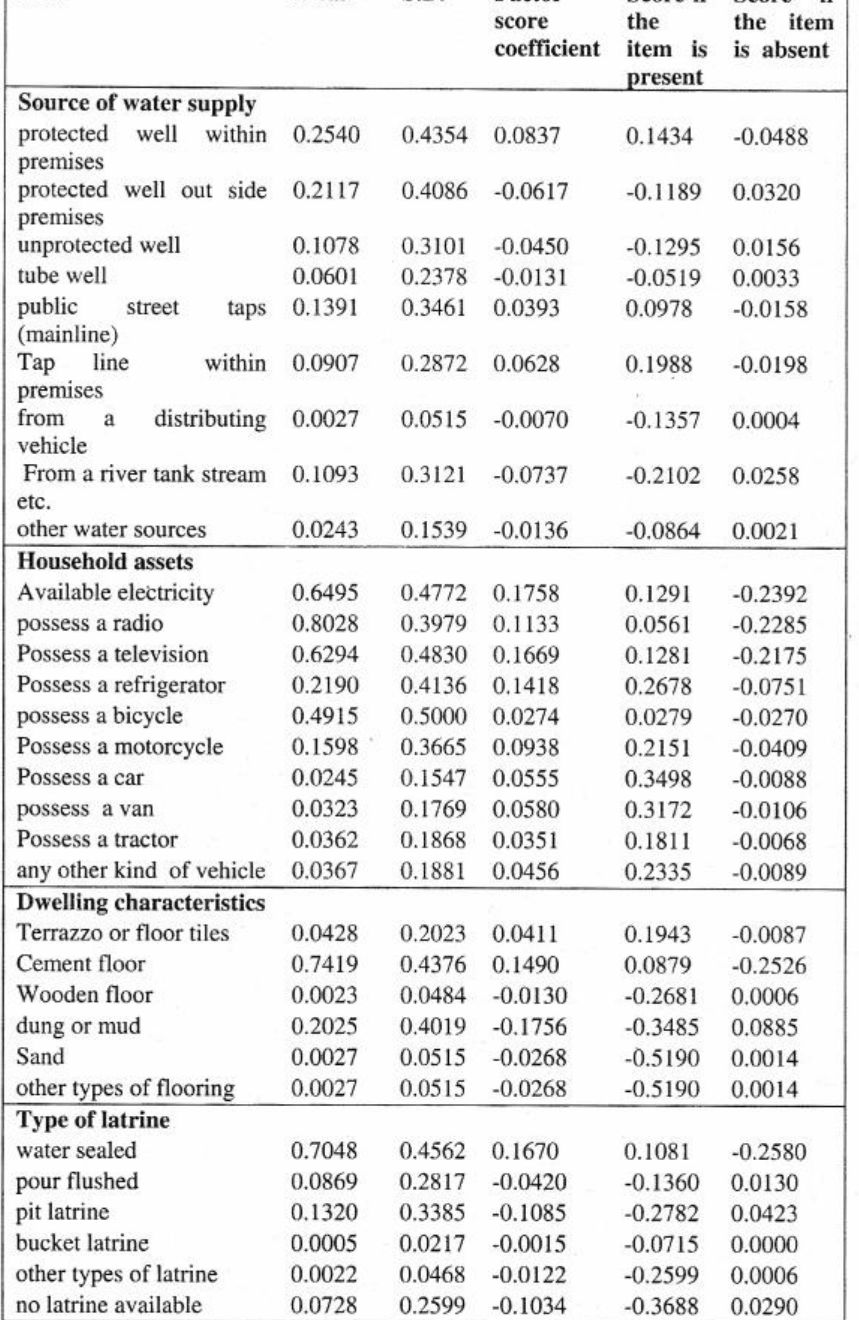
score the the item coefficient item is is absent present